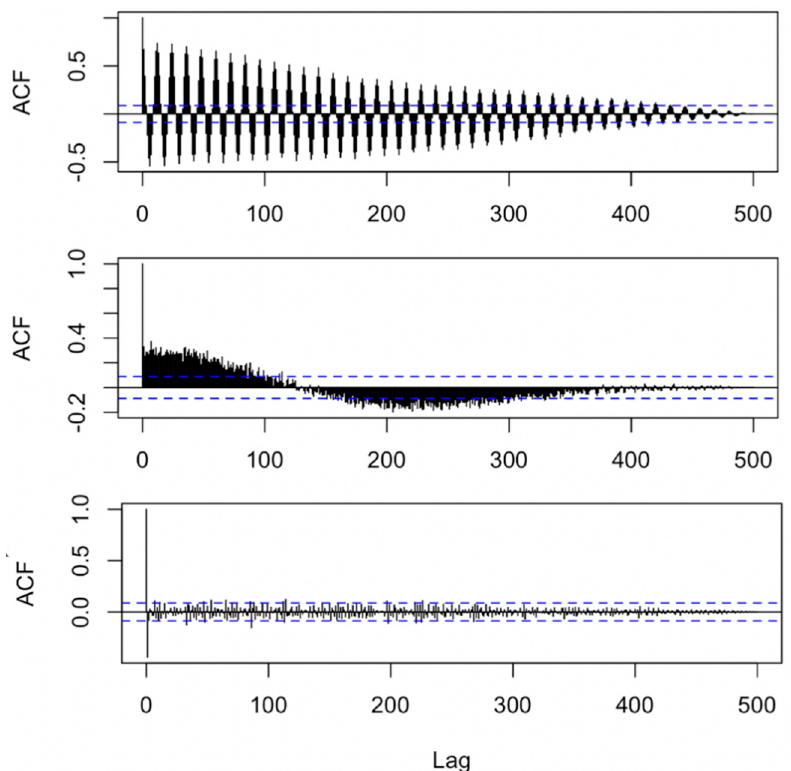
Figure 2. Top panel, autocorrelation of the boundary layer top height (BLH) monthly averages for the Wien/Hohe Warte station in Austria (WMO index = 11,035, 48.2486 ◦ N, 16.3564 ◦ E, 200 m asl) since 1978; middle panel, autocorrelation of residuals of BLH monthly anomalies linearly fitted with the least absolute deviation (LAD) regression method; bottom panel, same as middle panel after the removal of the lag-1 autocorrelation term.